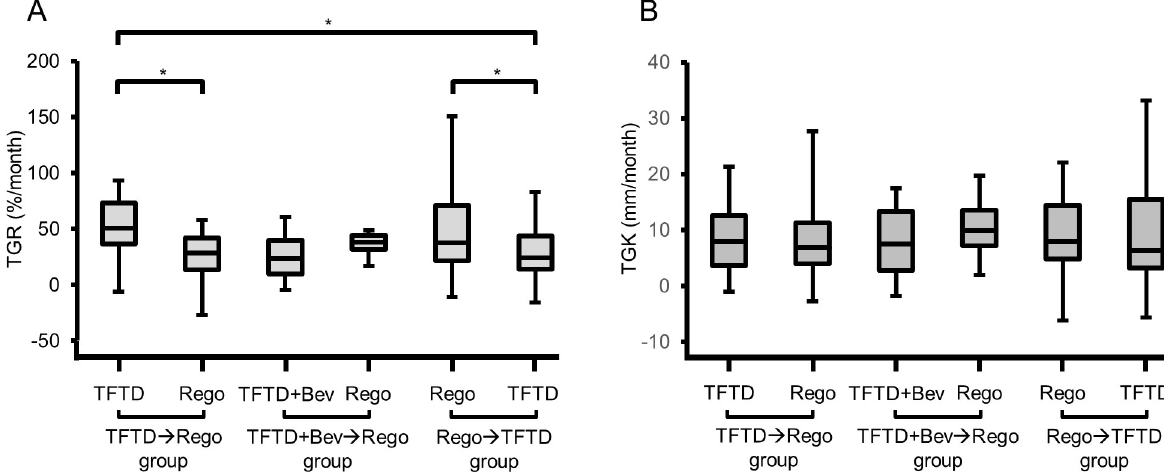
Fig 3. Distribution of the tumor growth rate and tumor growth kinetics. A. Distribution of the tumor growth rate. B. Distribution of the tumor growth kinetics. a p-value < 0.05.